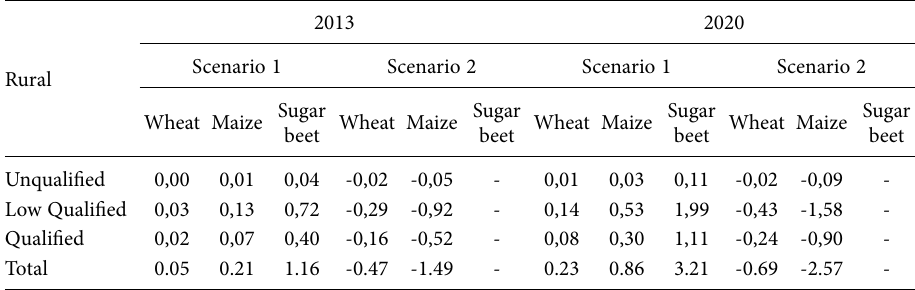
Table 6. Payments to labour force sourced by production increase-Open loop effect (million TL)*.